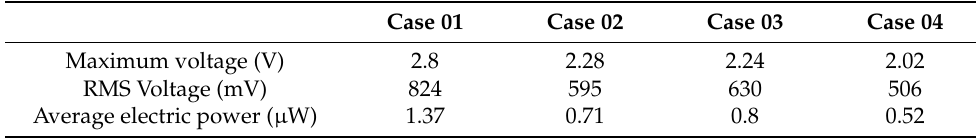
Table 3. Electrical output in each